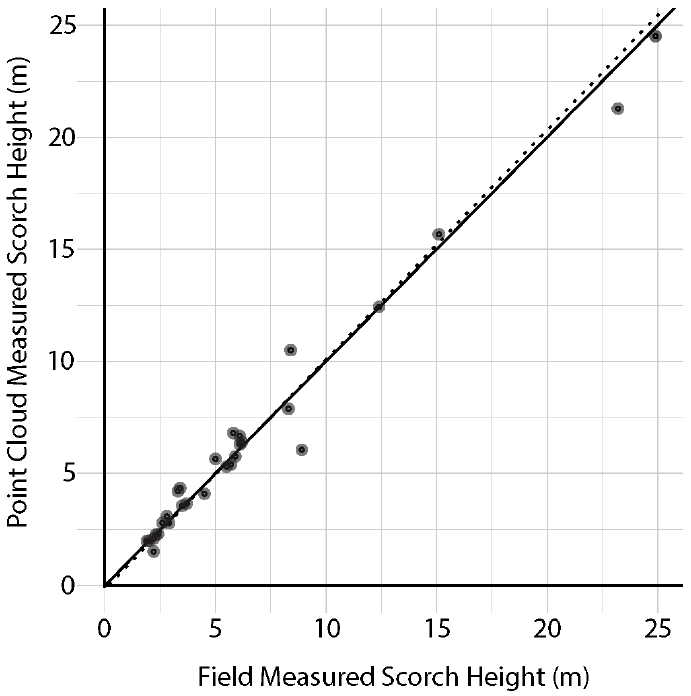
Figure 3. Comparison of field and point cloud measurements of scorch height ( n = 29). The solid line depicts a 1:1 field to point cloud relationship. Mean absolute error was 0.53 m. Mean absolute percentage error was 8.6% with an r-squared of 0.98 using a linear regression (dotted